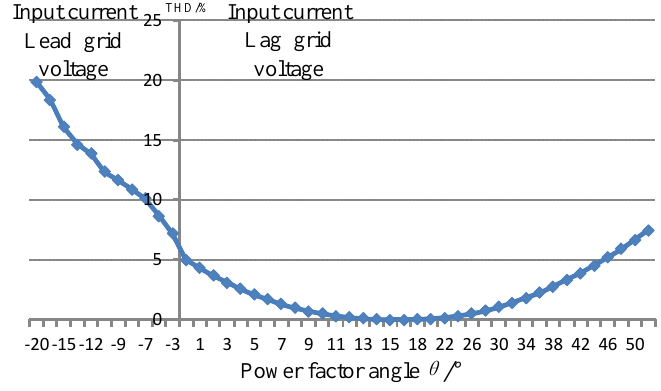
Figure 13. Relations between THD and power factor angle θ .